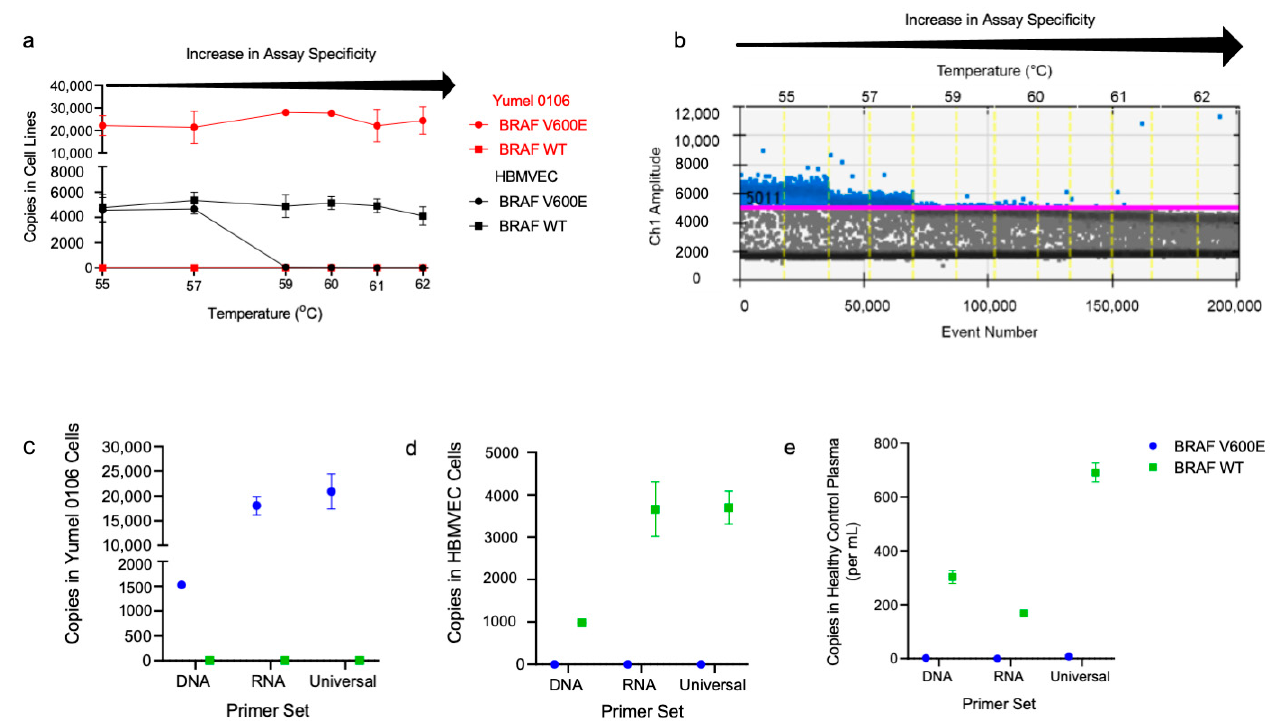
Figure 2. Optimization of the BRAF V600E and BRAF Wild Type ddPCR assay. ( a ) Absolute quantification of BRAF V600E (circle) and BRAF wild type (square) copies using the universal primer set in cDNA isolated from Yumel 0106 (red) and HBMVEC (black) cell lines are graphed with respect to temperature. Specificity of the assay increases with increasing annealing temperature, as shown by the arrow above the graph; ( b ) ddPCR 1D amplitude plot of HBMVEC cell line is shown. Mutant channel amplitude ( y -axis) with respect to event number (lower x -axis) and temperature (upper x -axis) is shown. Gates (pink line) were set with respect to wild type background population. Positive events, shown as blue droplets above the gate, decrease as the annealing temperature increases. Absolute quantification of BRAF V600E and BRAF WT copies and copies per mL of plasma were assessed in ( c ) Yumel 0106, ( d ) HBMVEC, and ( e ) healthy control plasma using DNA, mRNA, and universal primer sets and plotted as mean +/ − SD.